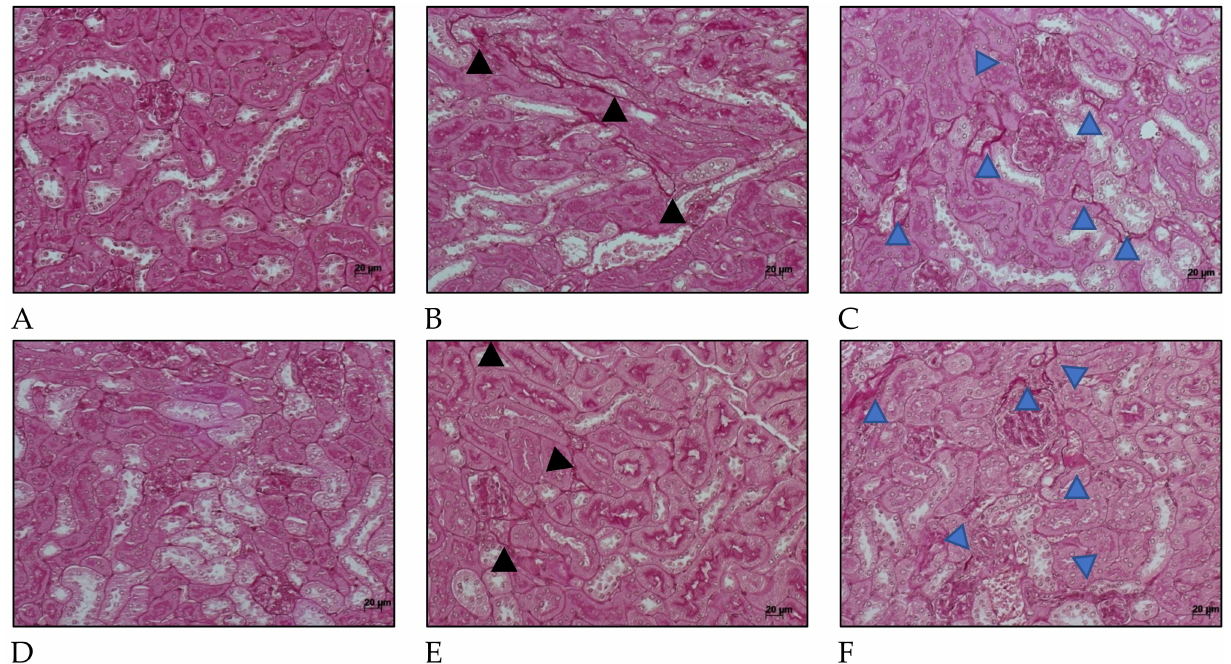
Figure 5. Histology micrography from C57BL/6 mice kidneys infected by Leptospira interrogans sorovar Manilae str. L495. Collagen deposition is evidenced by red staining in peritubular areas and the interstitium. ( A , D ) Negative controls injected with 200 µ L of PBS 15 days post infection (d.p.i.) and 30 d.p.i, respectively; ( B , C ) Kidneys of mice injected with 1 × 10 6 Leptospira and 2 × 10 8 Leptospira , respectively, at 15 d.p.i.; ( E , F ) Kidney from mice injected with 1 × 10 6 Leptospira and 2 × 10 8 Leptospira , respectively, at 30 d.p.i.; Periodic acid–Schiff staining; black and blue arrow heads: collagen deposition; lateral bar = 20 µ